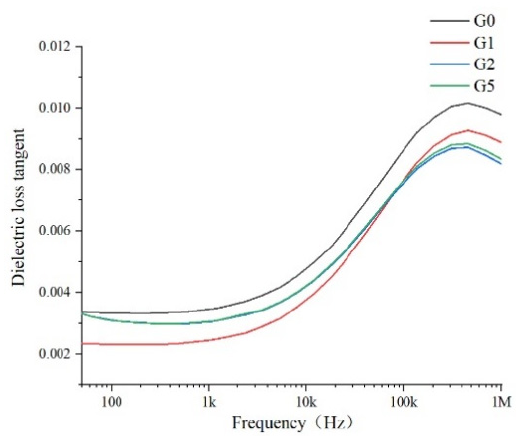
Figure 8. Dielectric loss tangent of the films.